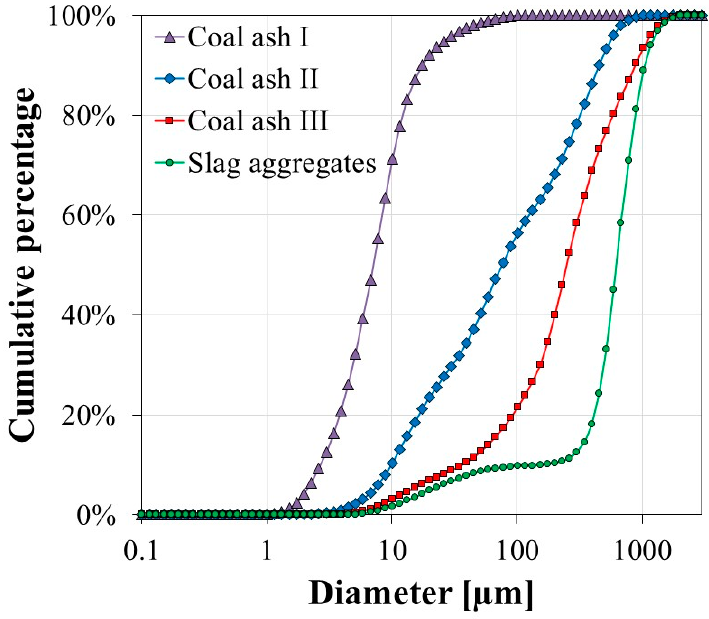
Figure 6. Particle size distribution of fillers (CA and slag aggregates).